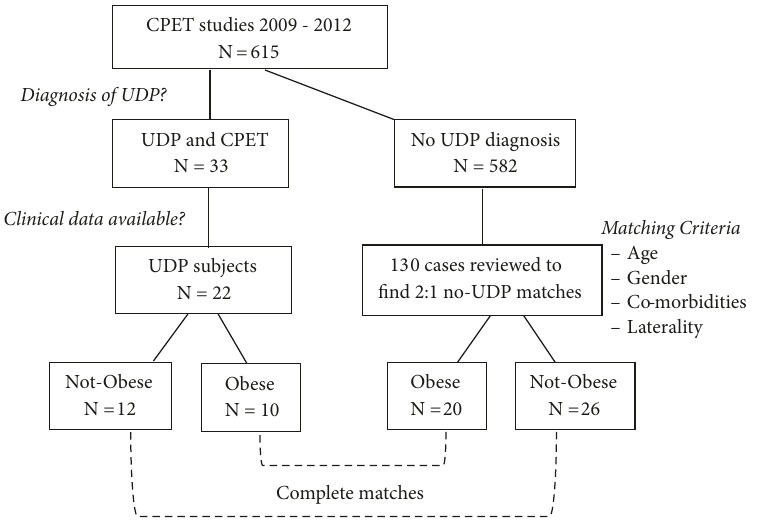
Figure 1: Flow diagram of the